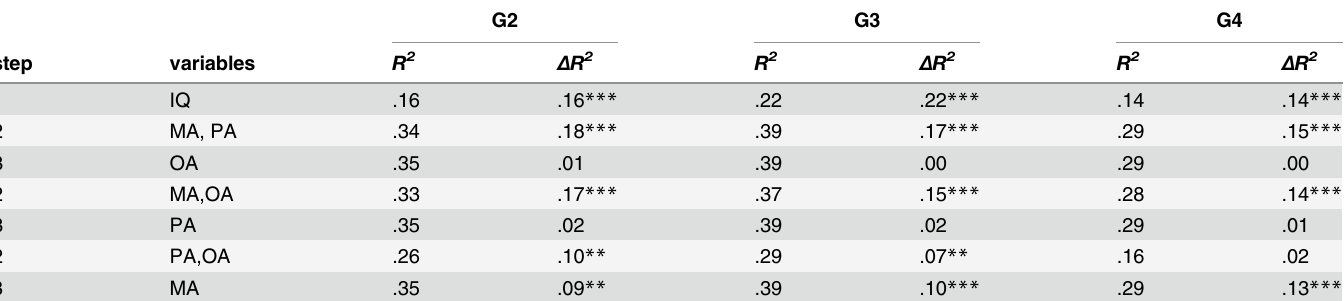
Table 4. Hierarchical regression explaining reading comprehension from one of three cognitive skills with IQ and other variables controlled.